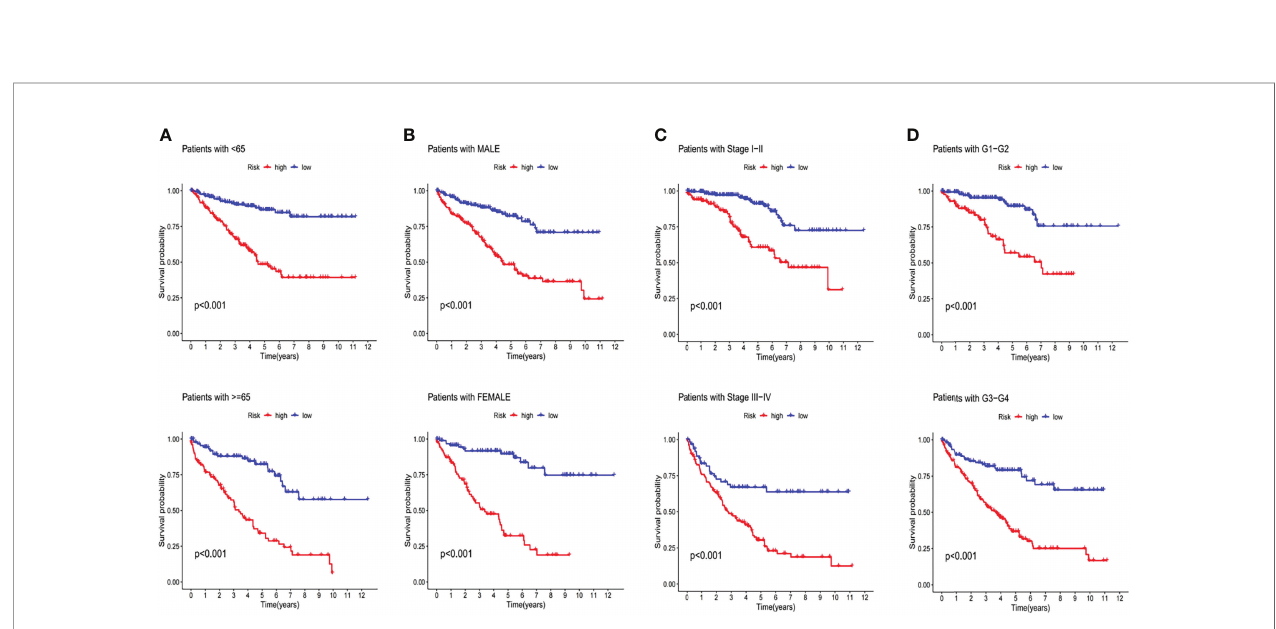
FIGURE 5 | The Validation of Independent Cohort. (A) Kaplan-Meier survival curves of the OS of patients in the high- and low-risk groups. (B) Distribution of m6A- related lncRNA model-based risk score for the Validation set. (C) Patterns of the survival time and survival status between both groups for the Validation set.